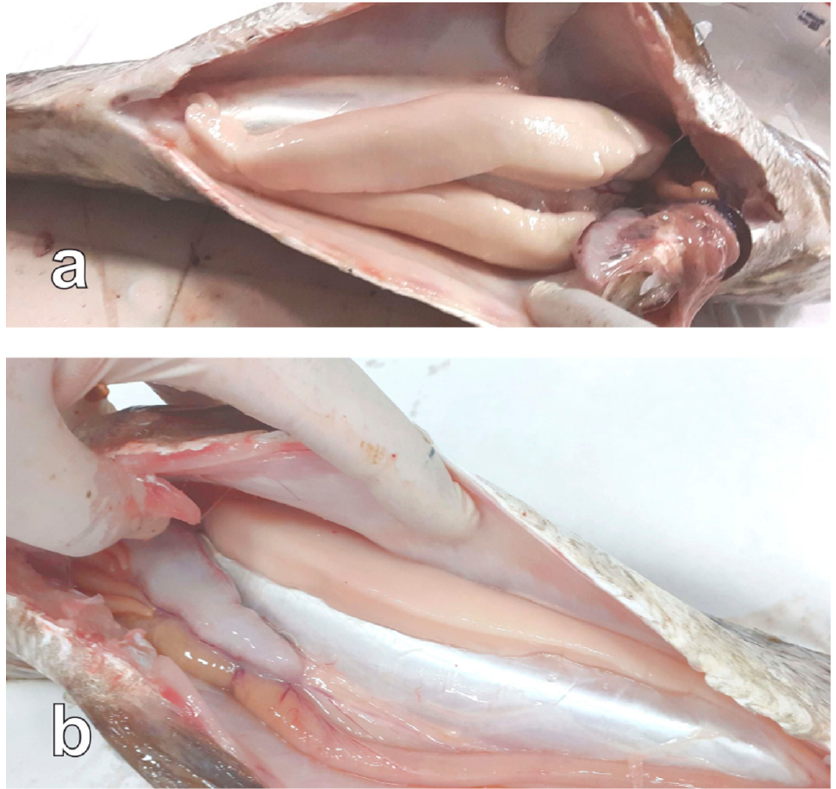
Figure 7. Meagre males sampled on 25 March 2021. ( a ) Specimen showing well developed testes. ( b ) Specimen showing only a well-developed